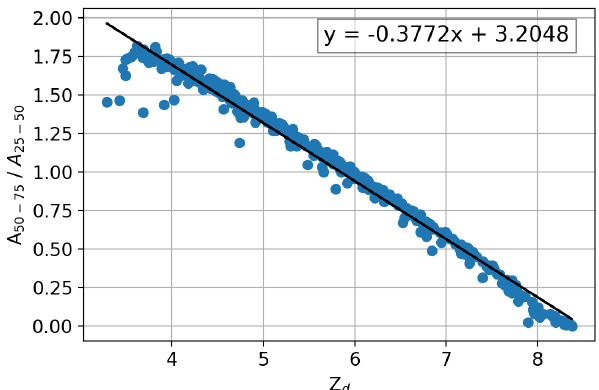
Figure 8. The ratio of the number of pixels between greyscale thresholds 50%–75% and 25%–50% (positive Z d ) that meet the criteria A 75 − 100 = 0 and A 50 − 75 > 0 (blue markers). These data are from model simulations of spherical particles in the size range 50 to